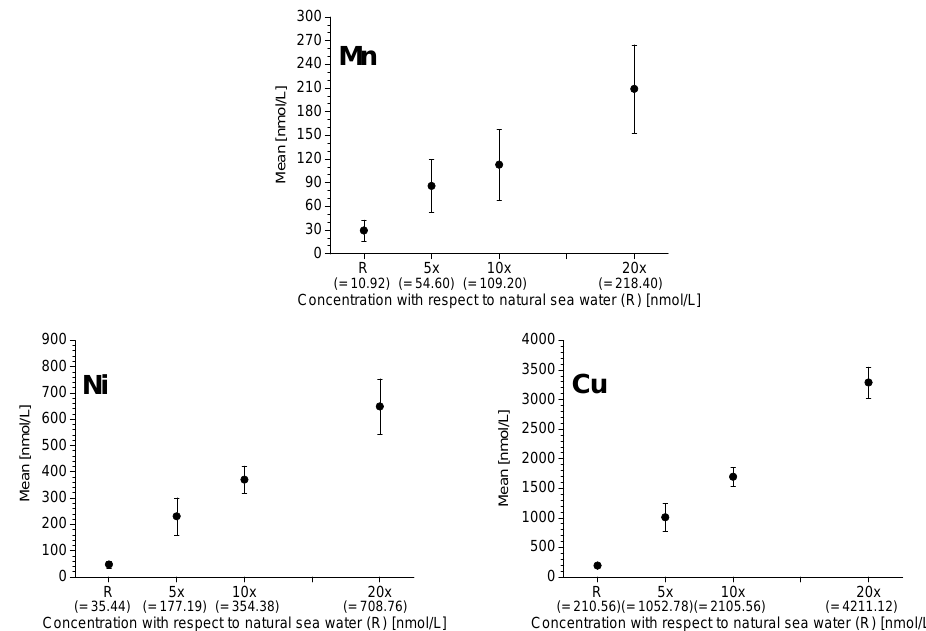
Fig. 2. Variation in the concentration [nmol/L] of Mn (top), Ni (lower left) and Cu (lower right) of each culture solution during the experiment; R = reference (natural sea water). Values in parentheses are theoretical values calculated on basis of pure sea water measurements performed before the